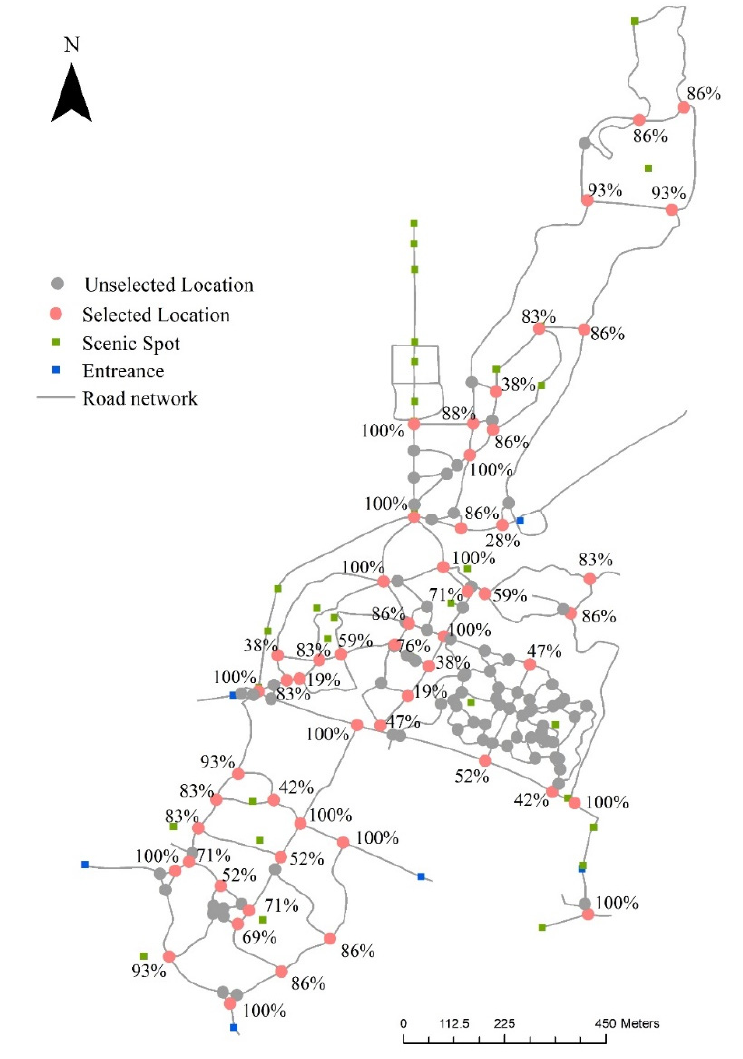
Figure 13. The probability that tourists believe that the location should be selected, the red circle is the selected, and annotation is the